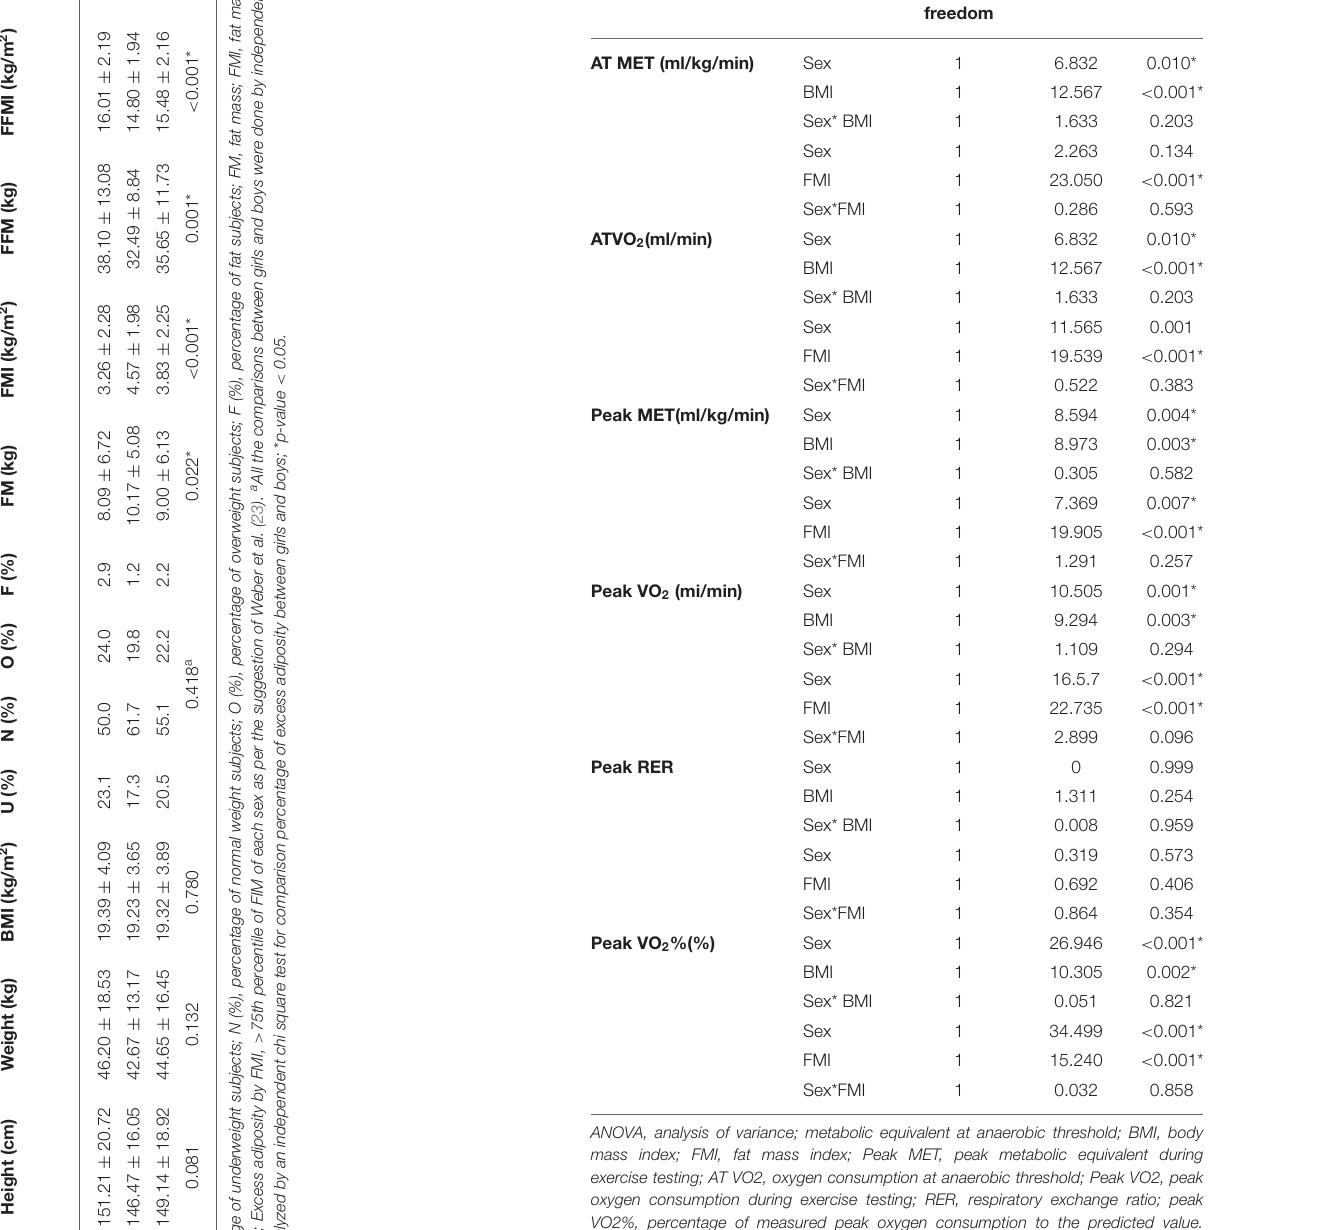
TABLE 2 | Two-way ANOVA results on the influence of sex, body adipose, and interaction between sex and body adipose on the cardiopulmonary fitness of patients with repaired tetralogy of fallot. Parameter Factor Degree of F-value P -value freedom